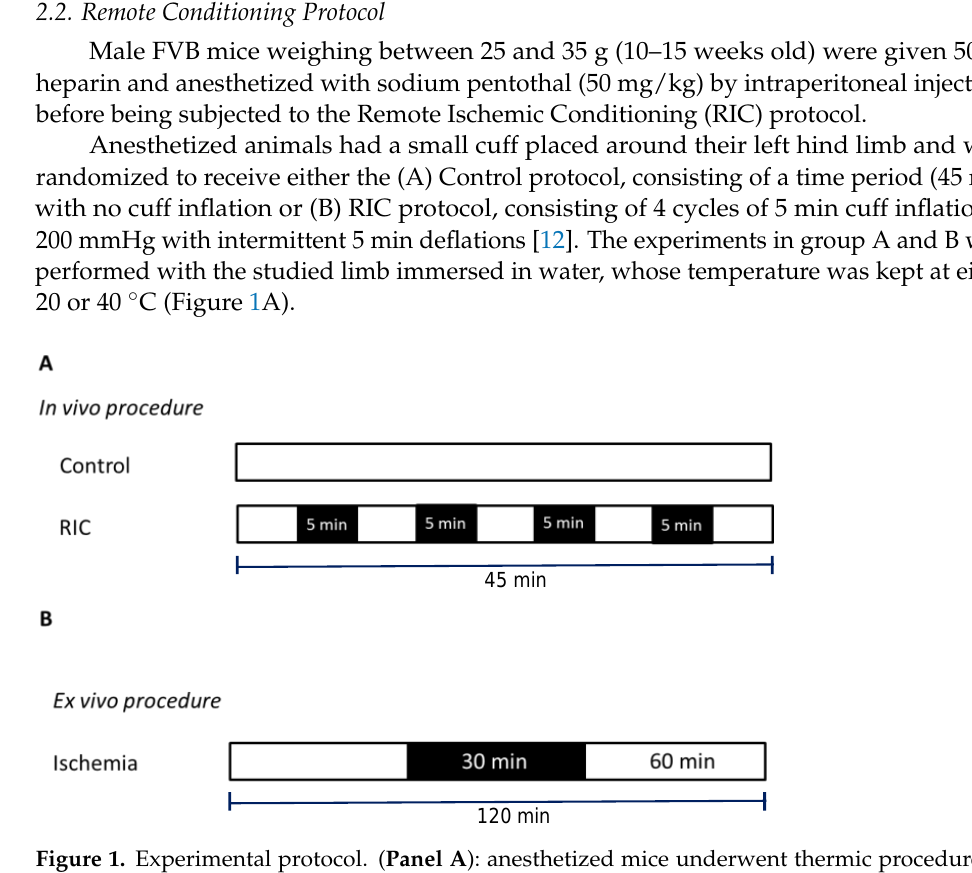
Figure 1. Experimental protocol. ( Panel A ): anesthetized mice underwent thermic procedures in which the left hindlimb was immersed in cold (20 ◦ C) or warm water (40 ◦ C) only (Controls) or underwent a remote conditioning (RIC) protocol while the hindlimb was immersed in water. ( Panel B ): isolated mice hearts underwent a global normothermic (37 ◦ C) ischemia/reperfusion procedure. Black boxes represent periods of ischemia; white boxes represent periods of normal perfusion.